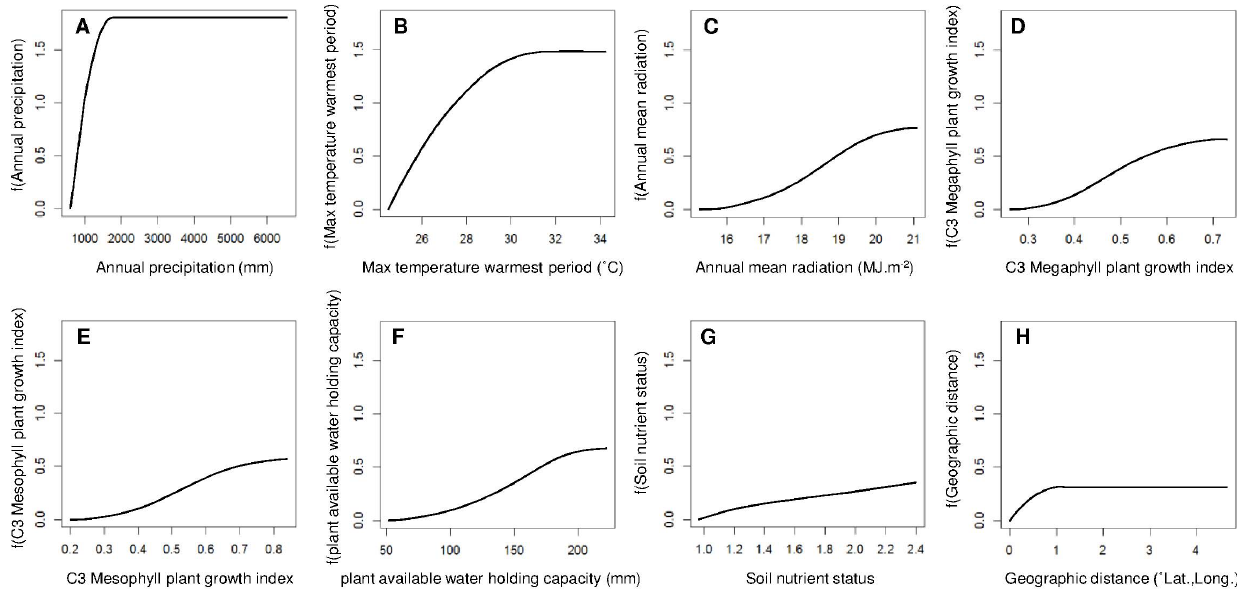
Figure 4. Compositional dissimilarity model response functions. GDM transformed environmental values as a function of the original environmental values for each of the eight explanatory variables included in the model of community compositional dissimilarity (( A ) – ( H )). The relative y-axis (transformed) range for the response of each variable indicates the relative strength of that variable in determining compositional dissimilarity, while the nonlinearity of the response indicates which sections of the environmental gradient have steeper predicted compositional dissimilarity.